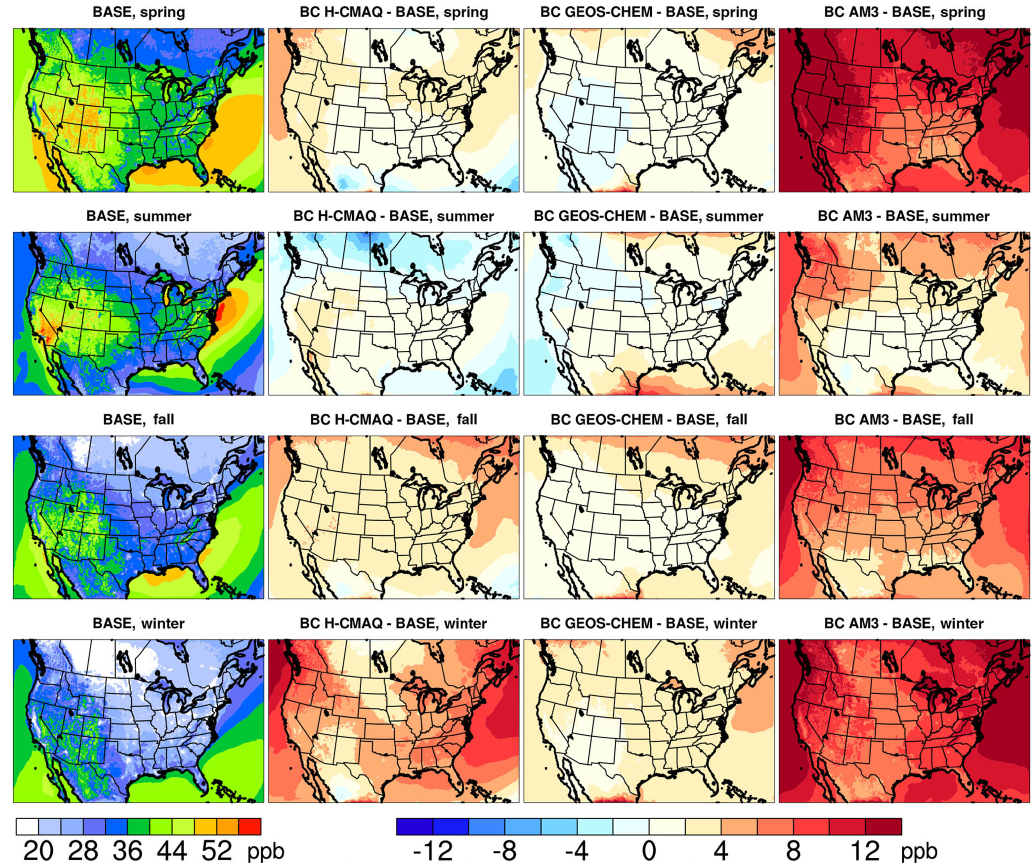
Figure 10. Maps of seasonal mean ozone mixing ratios at the surface for the BASE, BC H-CMAQ, BC GEOS-Chem, and BC-AM3 simu- lations. The left column shows the mixing ratios for the BASE simulation while the second, third, and fourth columns show the differences between BC H-CMAQ and BASE, BC GEOS-Chem and BASE, and BC AM3 and BASE,